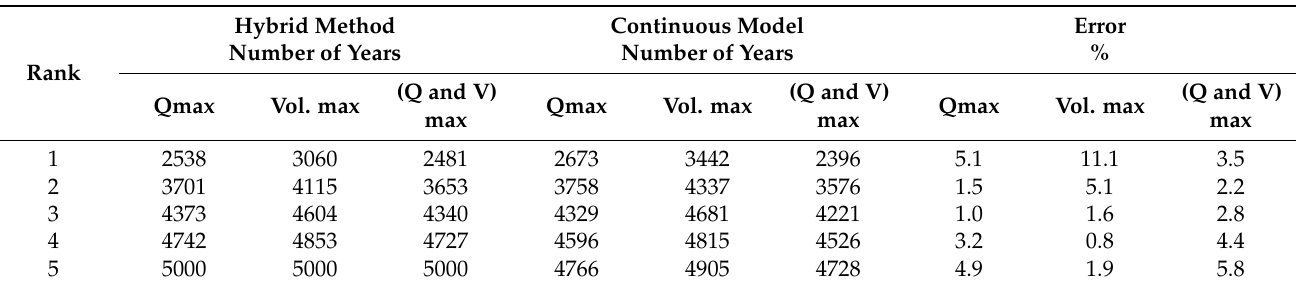
Table 1. Number of years, for each storm rank and model applied (hybrid and continuous model), where the annual peak-flow (Qmax.), maximum hydrograph volume (Vol. max), and Qmax. and Vol. max are identified (from a total of 5000 years analyzed). The error shows the difference (%), for each storm rank, between the number of events identified by applying the continuous model and the hybrid method.